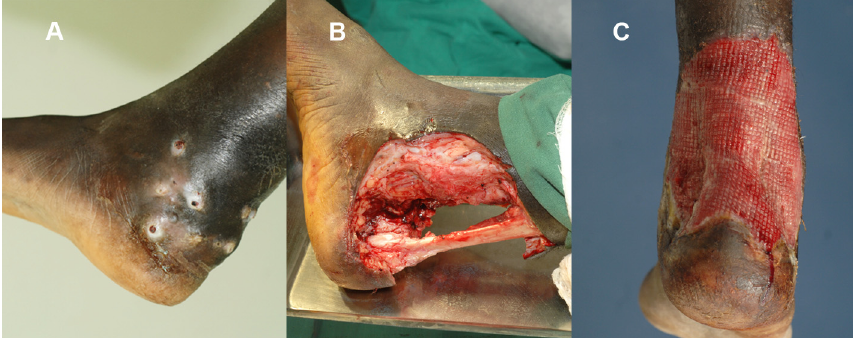
Fig 6. (A) Photograph showing an ankle-region eumycetoma. (B) The same lesion after wide local surgical excision. (C) The lesion with good granulation